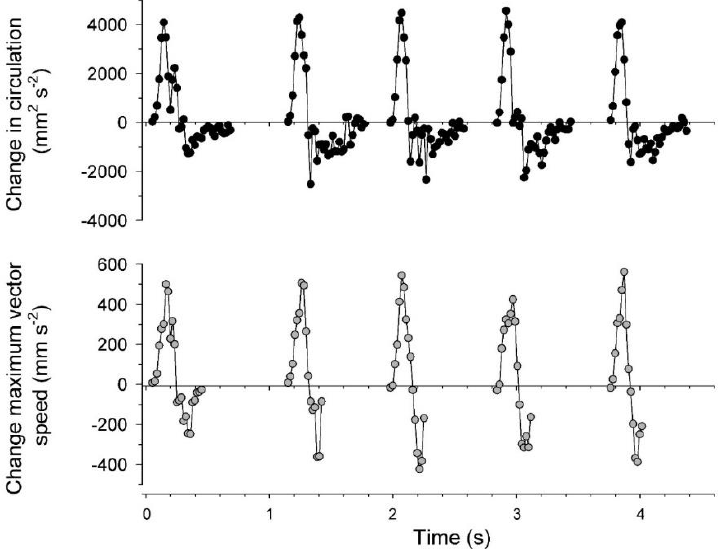
Figure 8. Correspondence between the change in combined circulation of starting vortices and the VIA region fluid speeds during bell contraction. All data represent 2D measurements derived from PIV images for the pulsation cycles depicted in Figures 2 and 3.